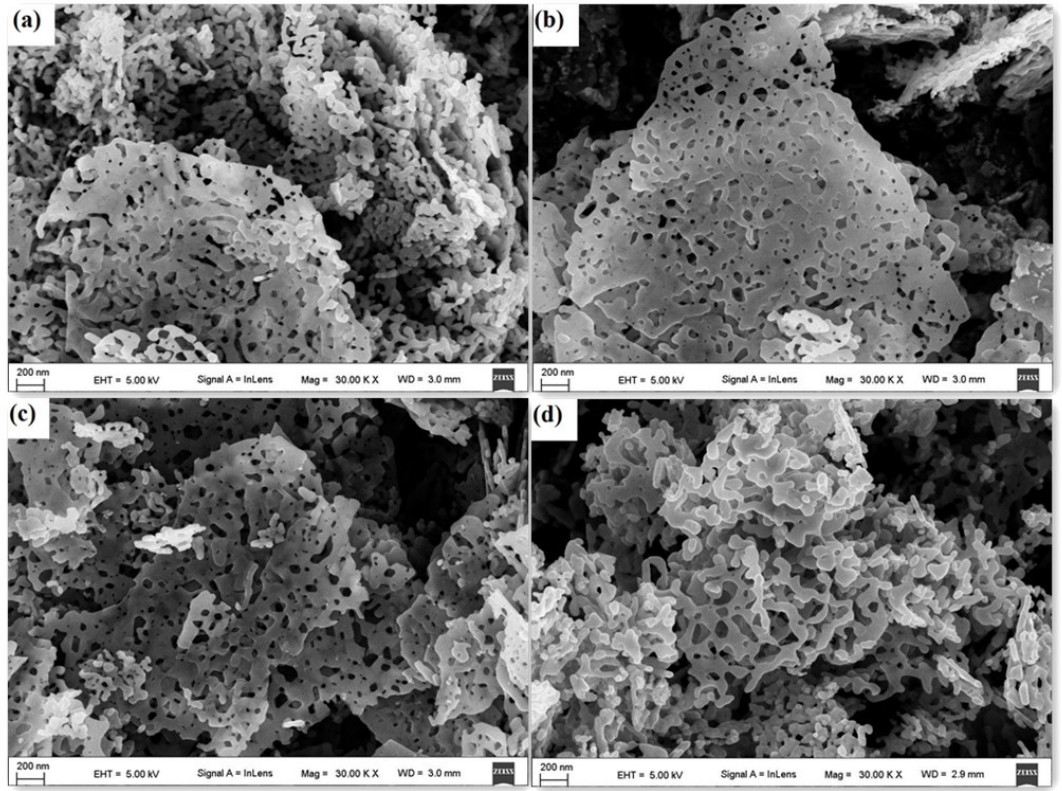
Figure 2. SEM images of ( a ) MCO-500; ( b ) MCO-550; ( c ) MCO-600; ( d ) MCO-650.